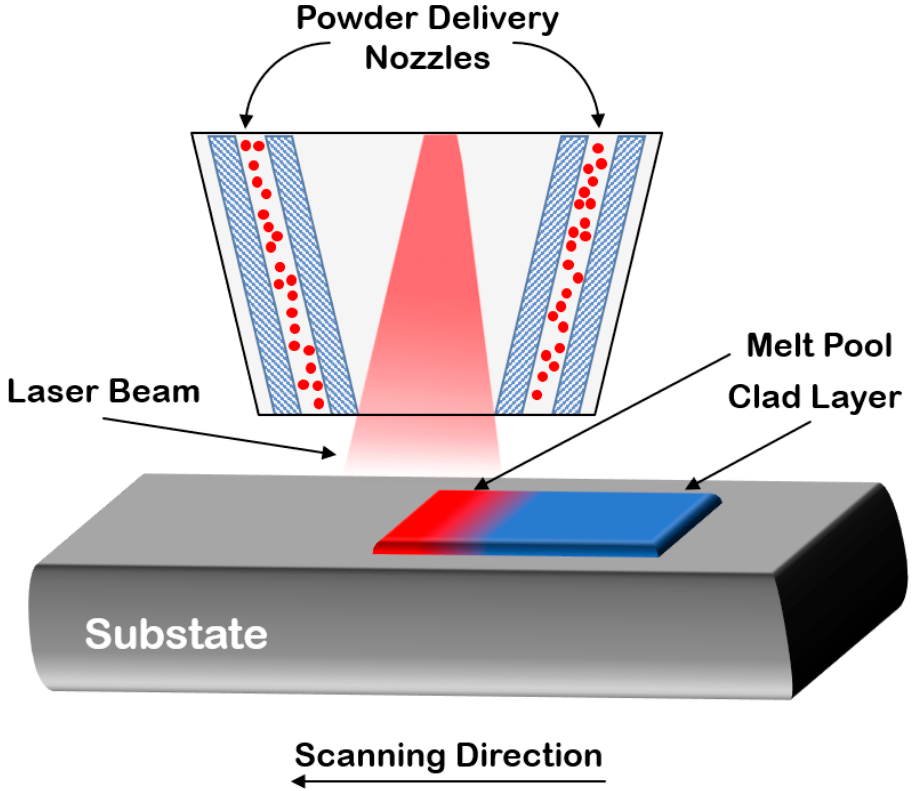
Figure 8. Schematic representing the laser-cladding process.